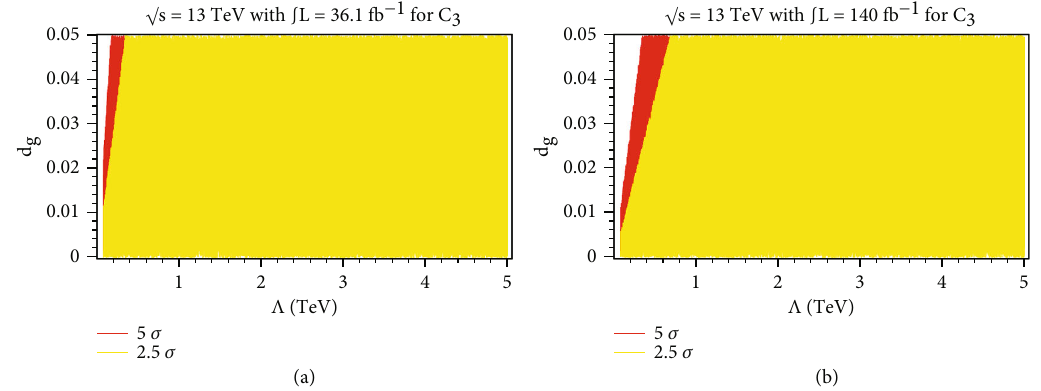
ffiffiffi p at = 13TeV energy at LHC for an integrated luminosity of (a) 36 : 1 fb − 1 and (b) 140fb − 1 S 3